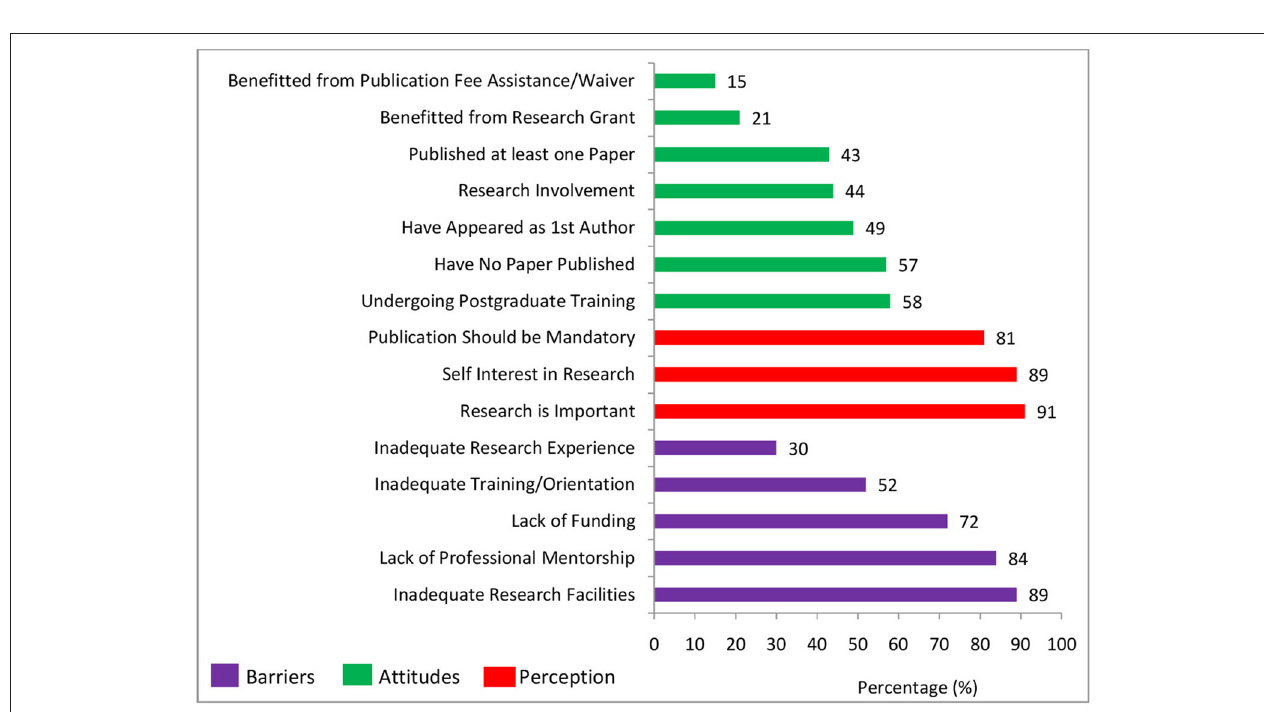
FIGURE 2 | An overview of barriers, attitudes, and perception of entire participants toward research and publishing of articles.